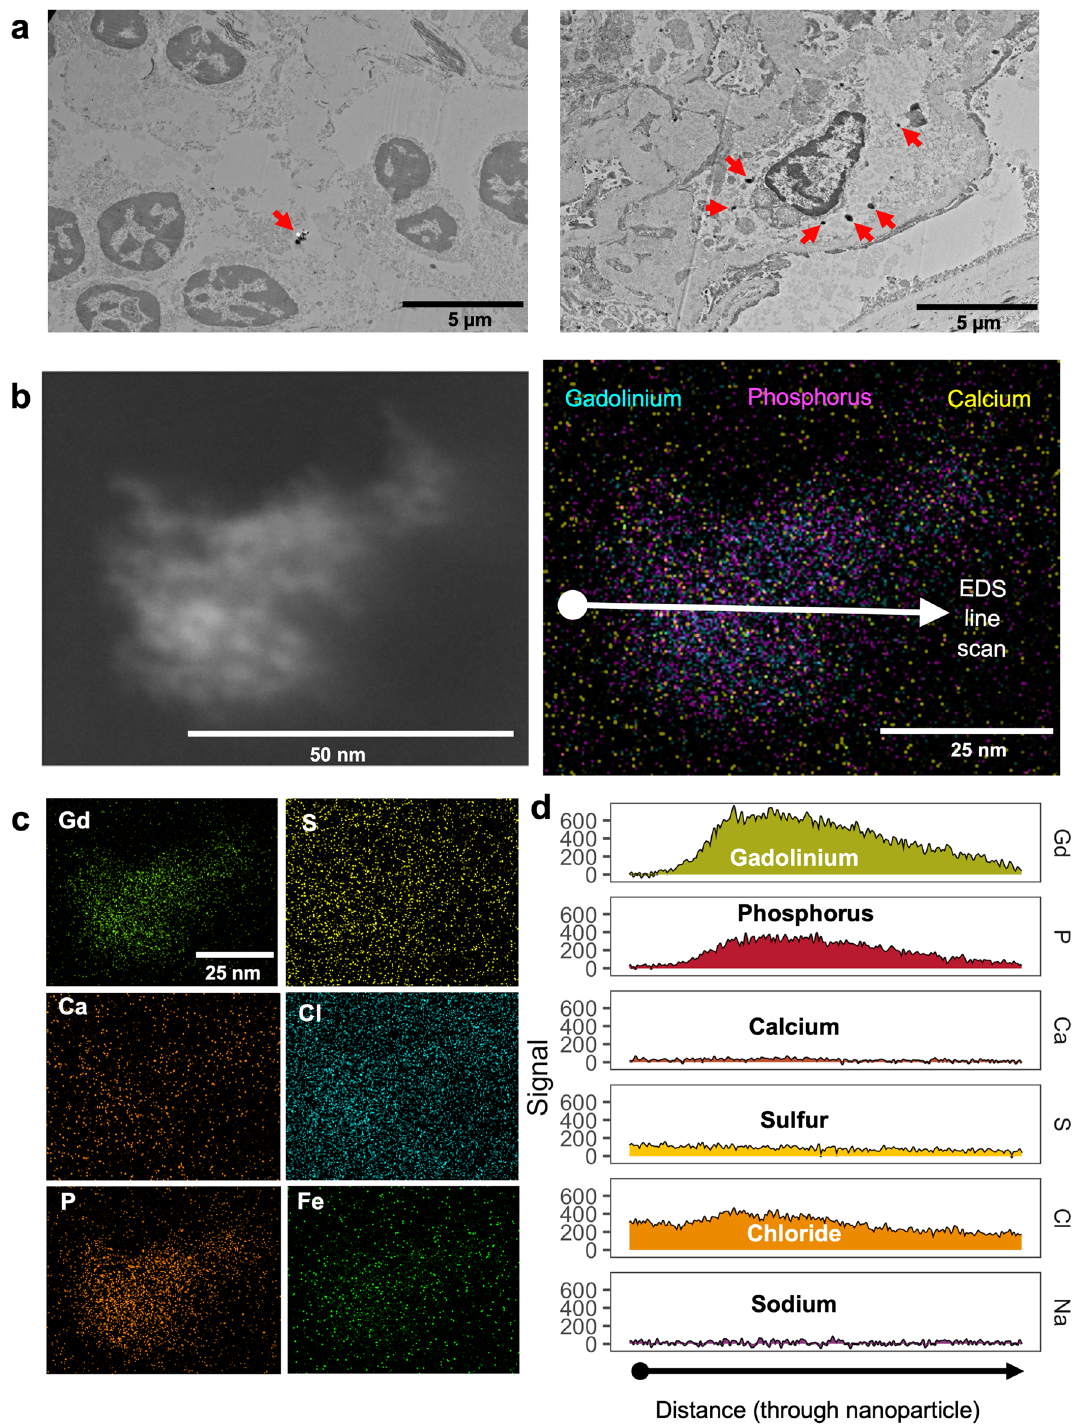
Figure 7. Routine use of MRI contrast agent resulted in intracellular gadolinium-rich nanoparticles. ( a ) Electron-dense intracellular precipitates (arrows) in human kidney. Hitachi H7700 TEM, AMT 16-megapixel digital camera. Calibration bars = 5 µm. ( b ) (Left) Darkfield scanning transmission electron micrograph of an electron-dense precipitate from the kidney specimen depicted in ( a ). (Right) 2D XEDS map of the nanoparticle in ( b ). ( c ) 2D XEDS mapping for gadolinium, calcium, phosphorus, sulfur, chlorine, and iron of the nanoparticle shown in ( b ). ( d ) XEDS line scan through the particle shown in ( b ). JEOL NEOARM 200 kV aberration-corrected scanning transmission electron microscope with dual EDS x-ray analysis